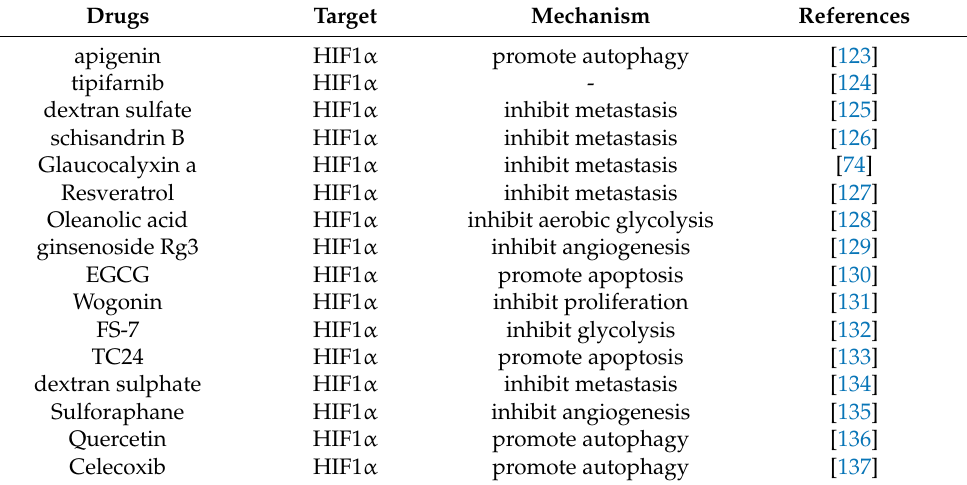
Table 8. Small molecule drugs targeting HIF to inhibit gastric